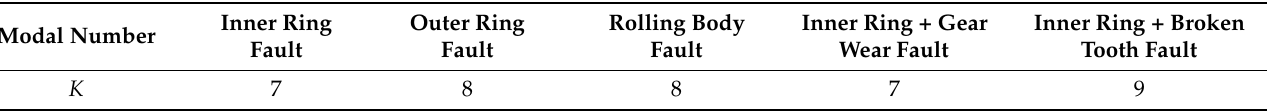
Table 3. The number of modes obtained by decomposing different fault signals.